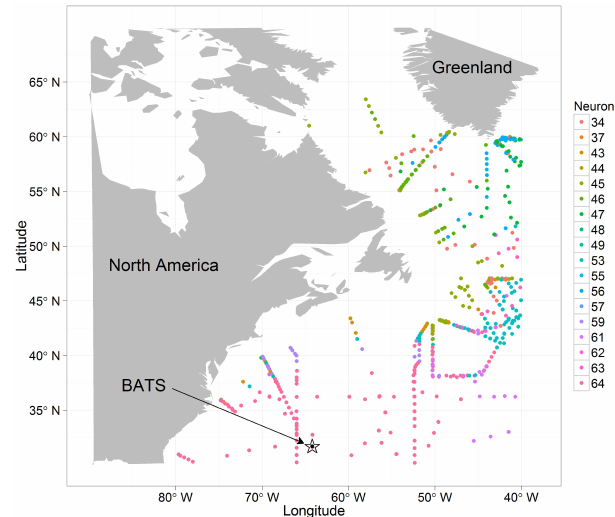
Fig. 16. Distribution of assigned neurons in the northwestern At- lantic region for optimal C T SOMLO model (30 to 70 ◦ N and 40 to 85 ◦ W). Numbers represent the neuron each measurement was assigned to (maximum of